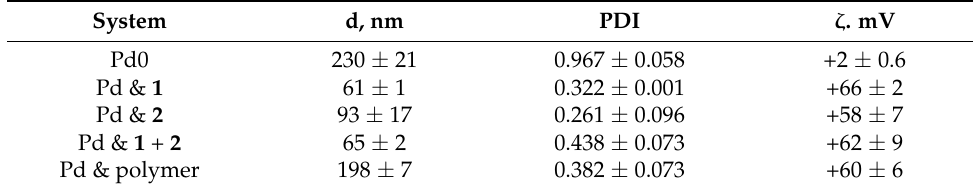
Table 2. DLS and ELS data of aqueous solutions of Pd nanoparticles alone and stabilized by macro- cycles 1 , 2 and their mixture before and after CuAAC polymerization.